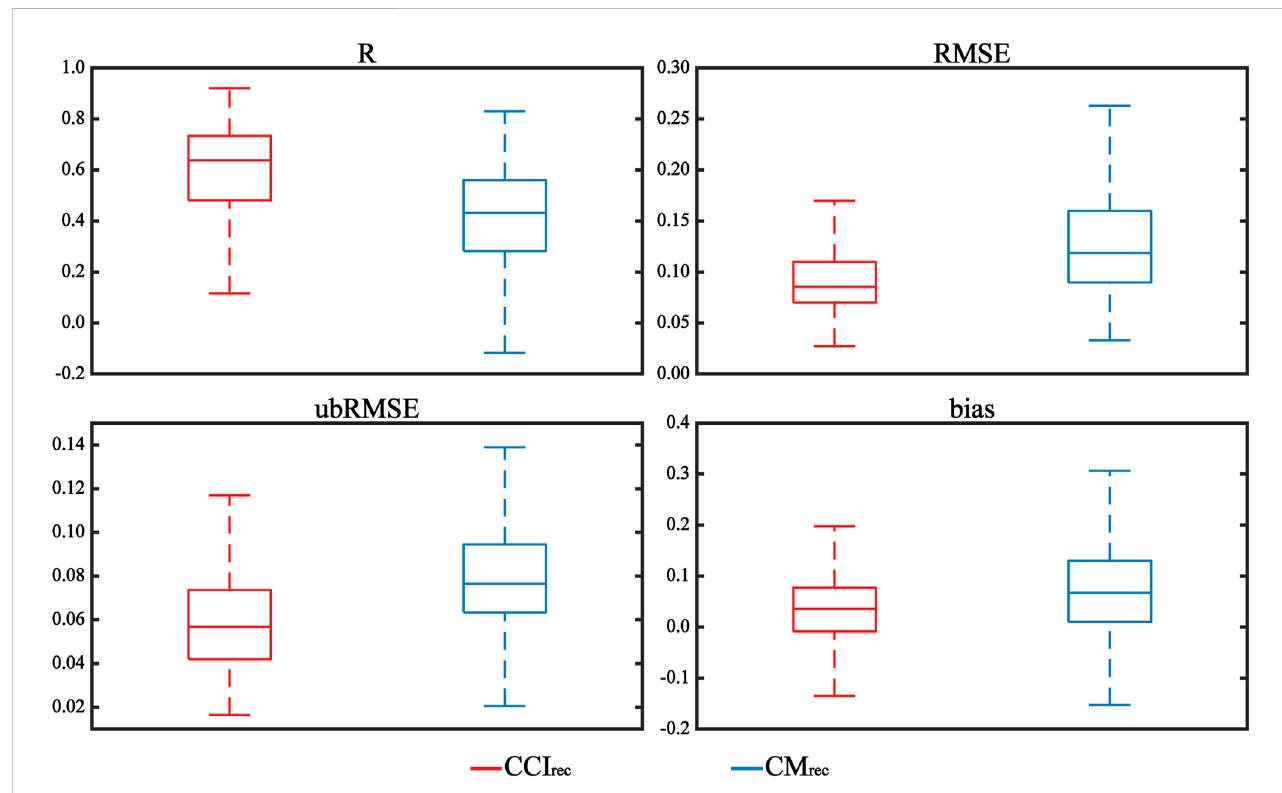
FIGURE 11 Boxplots of R, RMSE, ubRMSE and bias of CCI rec and CM rec evaluated with in-situ observations from the global International Soil Moisture Network